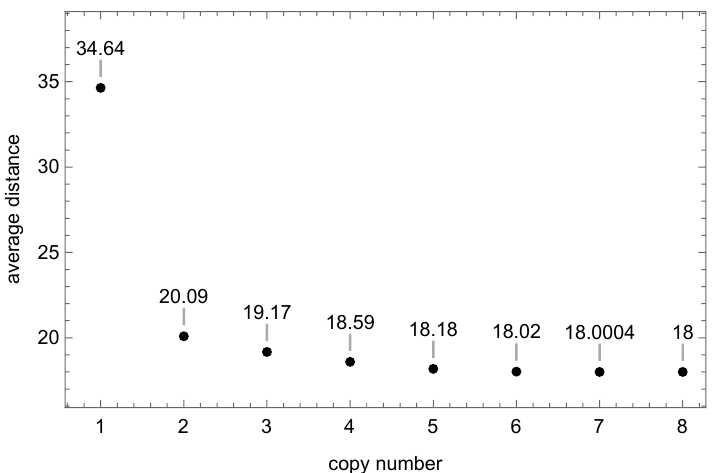
n ,0,0,0 minus distance from the { } n 1,0,0,0 , averaged over all the simplices of the configuration. { − }